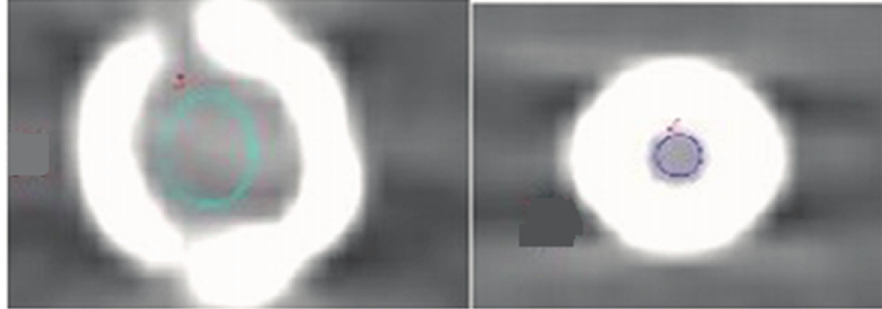
Figure 7. The region of interest was placed in the inner stent lumen for measurement of image noise. The colored circles indicate measurement inside the stent